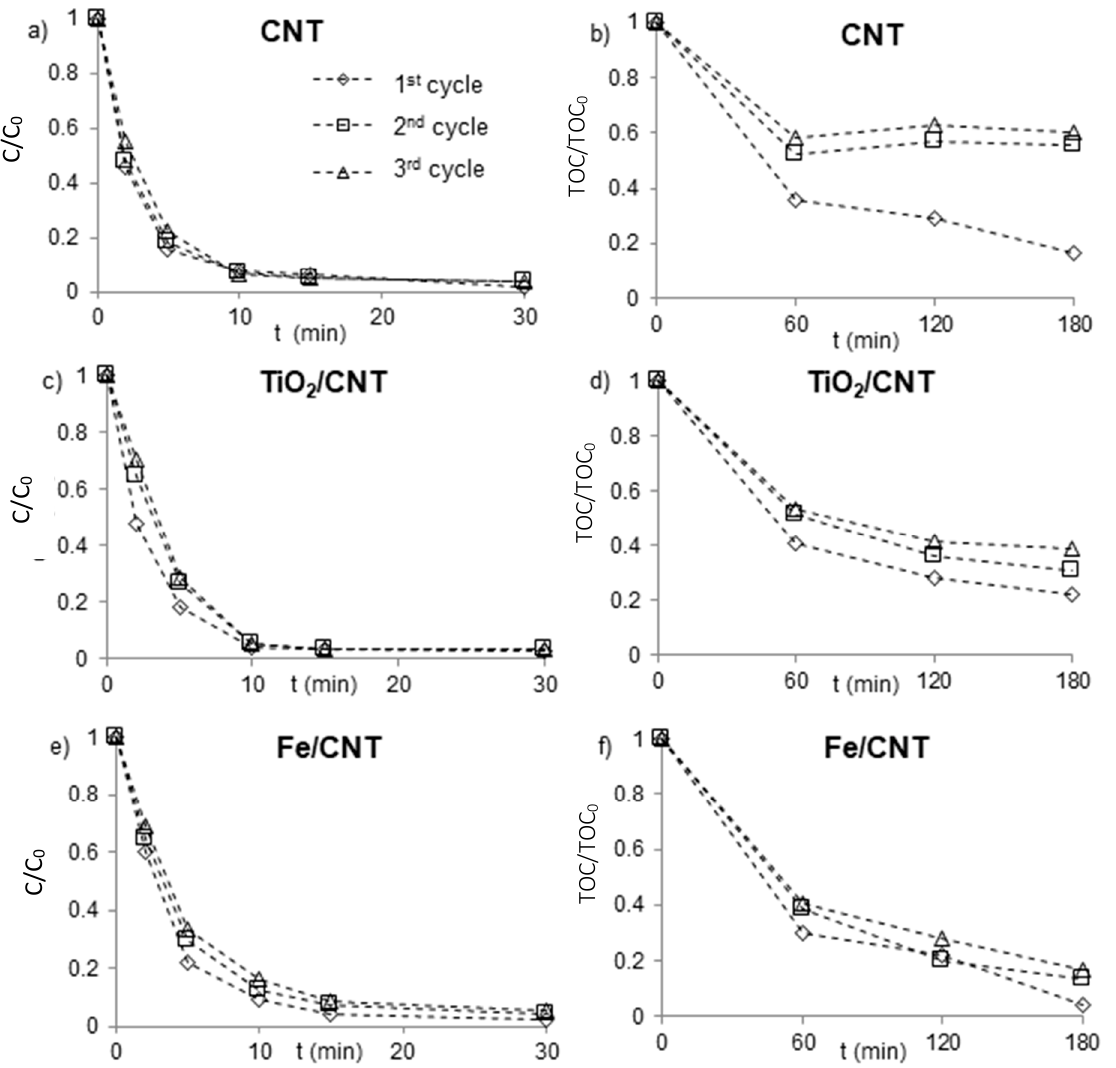
Figure 7. Dimensionless SMX ( a , c , e ) and TOC ( b , d , f ) concentration during reutilization experiments of photocatalytic ozonation with H 2 O 2 (L / O 3 / H 2 O 2 ) in the presence of CNT, TiO 2 / CNT, and Fe /